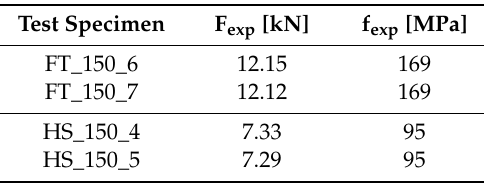
Table 4. Estimation of the actual glass